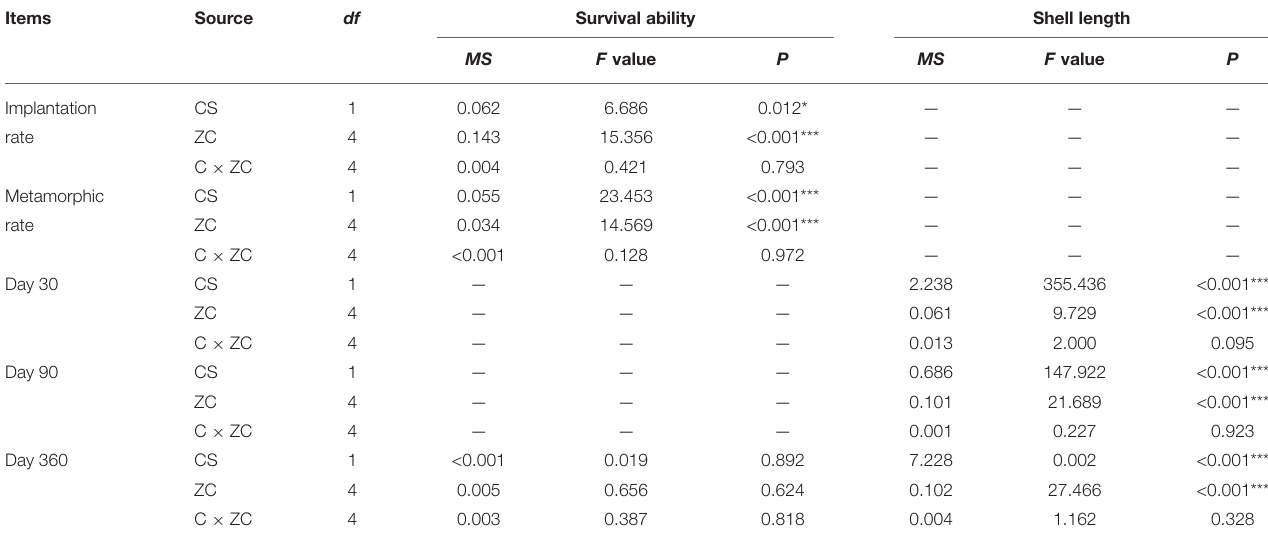
TABLE 1 | Analysis of variance (ANOVA) showing giant clam species (CS) and zooxanthellae clade (ZC) effects on survival and growth of each experimental group at different time points. Items